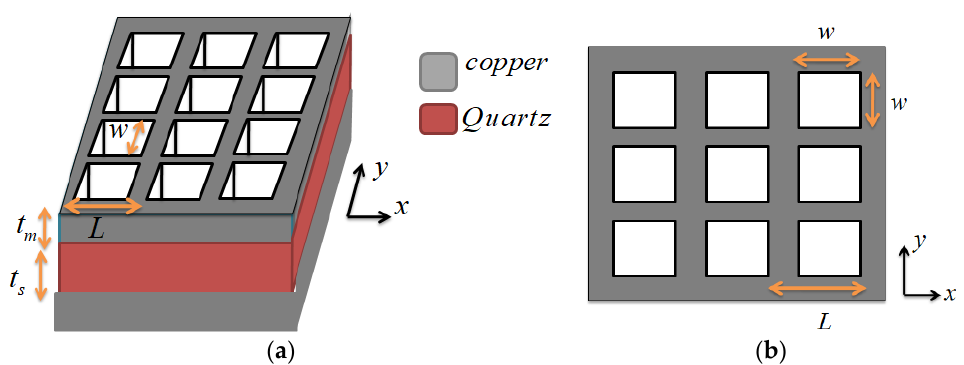
Figure 1. ( a ) Structure of the proposed absorber composed of a hole array drilled into a metallic layer and a grounded dielectric slab ( b ) top view of hole